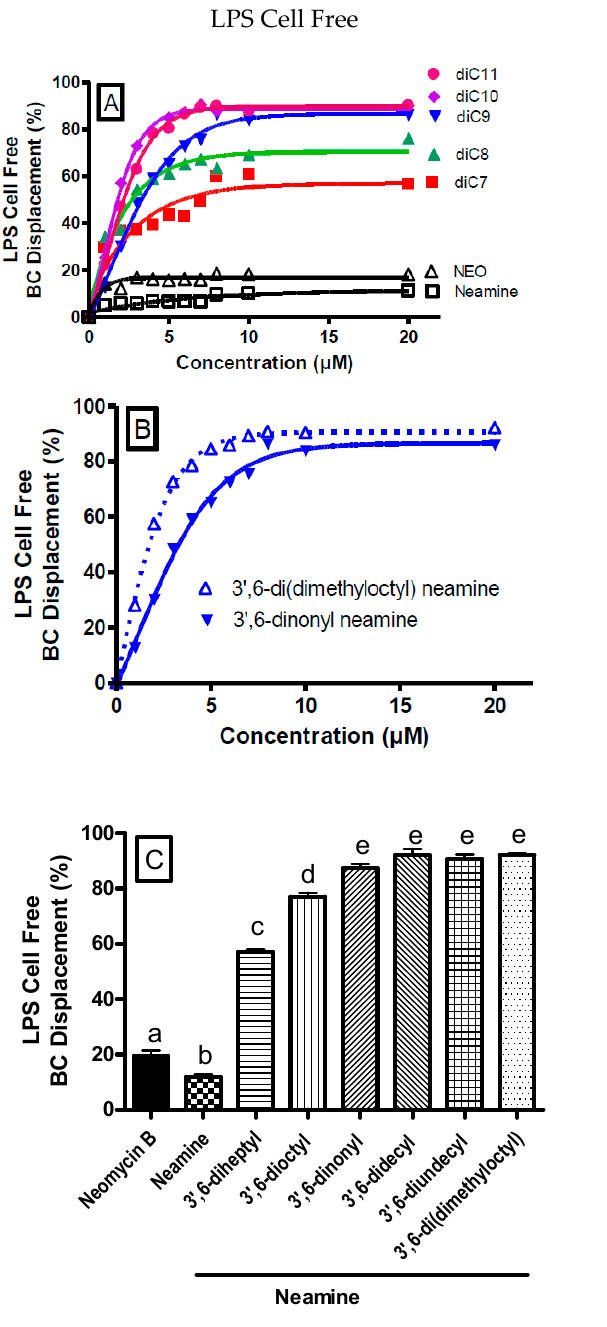
Figure 4. Relative affinity of 3 ′ ,6-dihomoalkyl neamine derivatives for cell-free LPS ( A , B ) or LPS from P. aeruginosa ( D , E ) plot for dose-dependent displacement of the fluorescent probe BODIPY-TR-cadaverine from LPS induced by 3 ′ ,6-diheptyl neamine ( ■ ), 3 ′ ,6-dioctyl neamine ( ▲ ), 3 ′ ,6-dinonyl neamine ( ▼ ), 3 ′ ,6-didecyl neamine ( ♦ ), 3 ′ ,6-diundecyl neamine ( ● ), neamine ( □ ), and neomycin B ( ∆ ). Fluorescence intensities were normalized as the percentages of probe displacement compared to the probe displacement induced by polymyxin B (50 μ M). Error bars are omitted for the sake of clarity (SEM ≈ 4%). ( C , F ) Percentage of the maximum effect when the derivatives were at a concentration of 20 μ M. Statistical assays were one-way ANOVA analysis with Tukey’s multiple comparison test. In each group, the bars with different letters indicate significant differences ( p < 0.001).